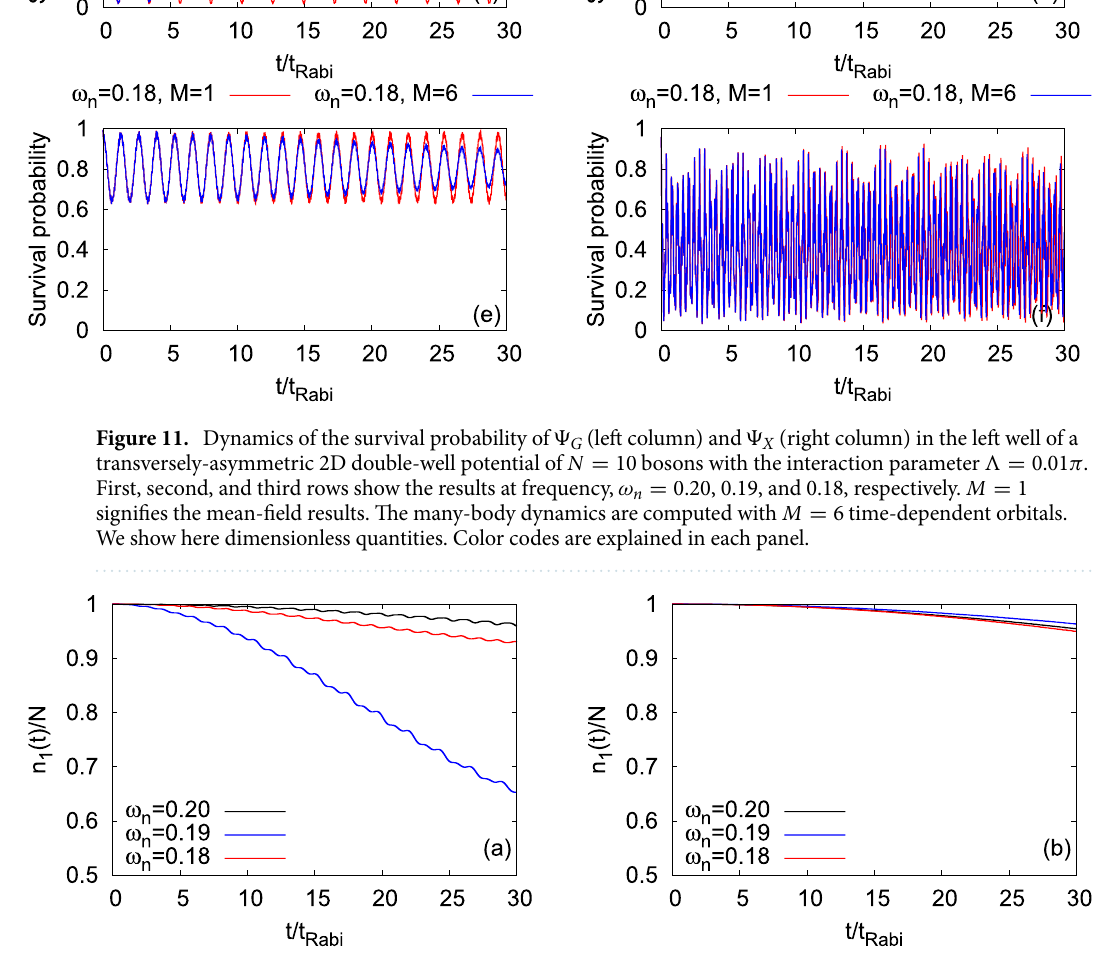
n t ) 1 ( N , in a transversely- 10 and the interaction parameter = 6 =